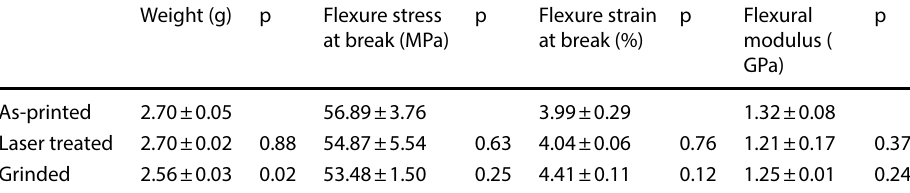
Data represents mean ± SD of triplicates; p test groups compared to